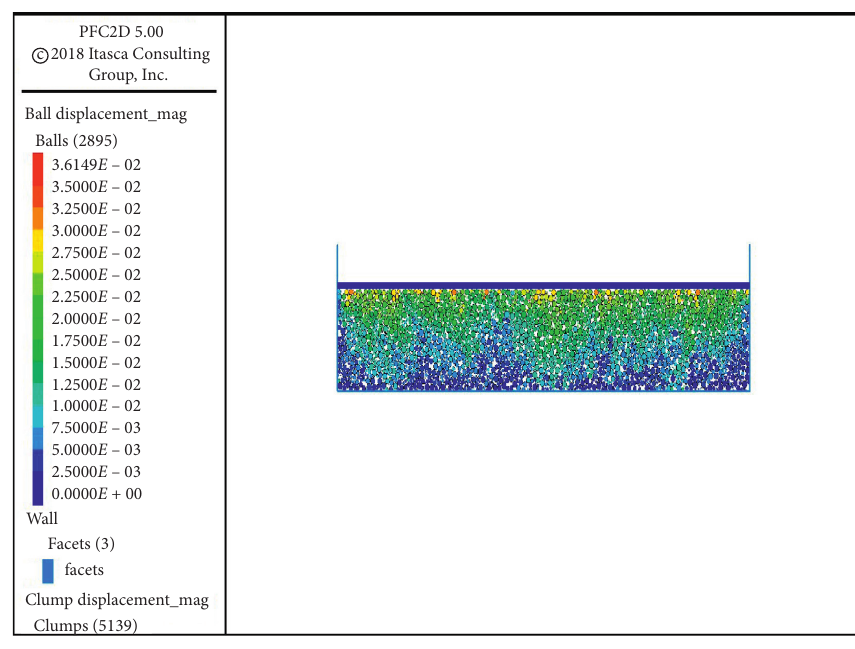
Figure 10: Discrete element particle migration map of 30cm thick reclaimed soil with three compactions.